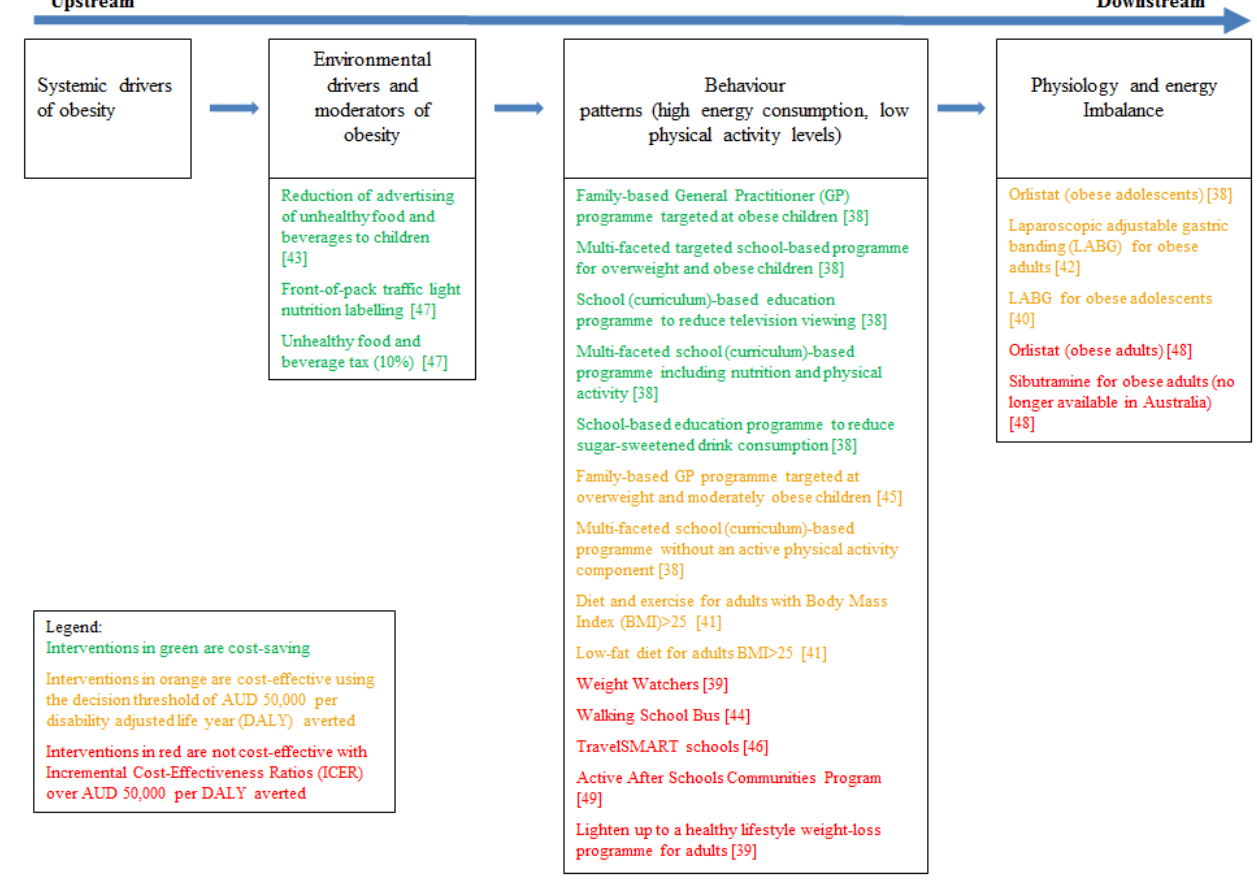
Figure 1. Interventions from the Assessing Cost Effectiveness (ACE) Obesity and ACE-Prevention studies, mapped to the continuum of obesity determinants and